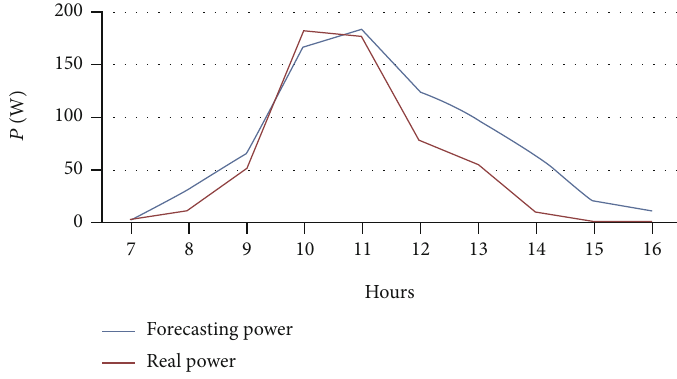
Figure 11: Predicted (forecast) and measured (real) power for 20.01.2009.